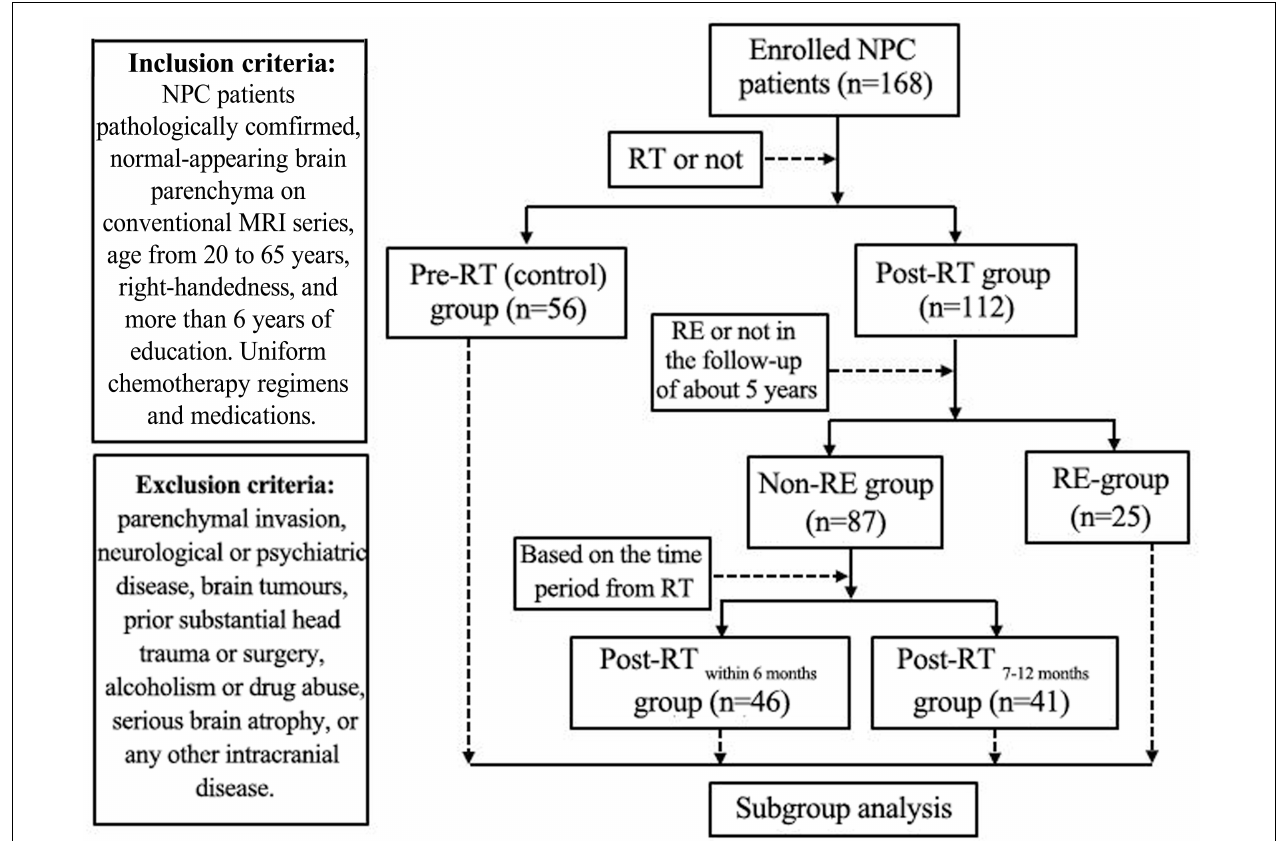
FIGURE 1 | Flow diagram for the NPC patient selection and grouping. Patients were enrolled into the study and imaged at various times relative to their RT. In some Post-RT cases, the imaging revealed characteristic signs of RE. Following imaging, patients were sorted into groups as shown in the diagram based on when they were imaged and whether or not evidence of RE was